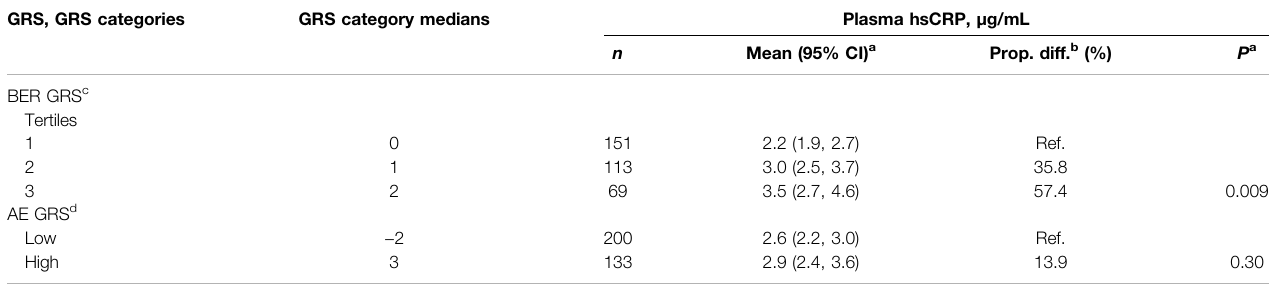
TABLE 2| Mean a plasma high sensitivity C-reactive protein (hsCRP) concentrationsaccording tocategories ofDNA baseexcision repair (BER) and antioxidant enzyme (AE) genetic risk scores (GRS), in the pooled MAP I and MAP II cross-sectional studies. GRS, GRS categories